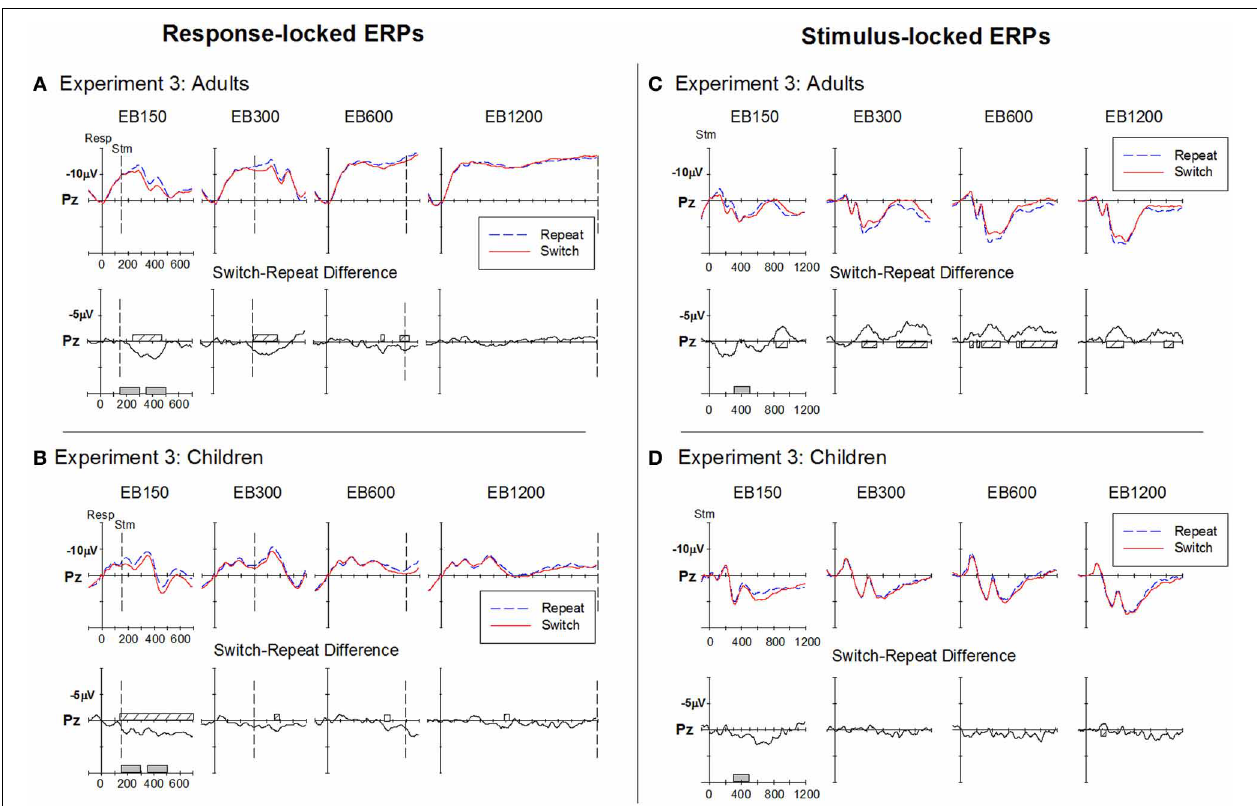
FIGURE 7 | Response-locked (A,B) and stimulus-locked (B,C) ERPs for switch and repeat trials and (switch—repeat) difference waveforms at Pz for Experiment 3. Filled gray bars on timeline indicate epochs used for mean